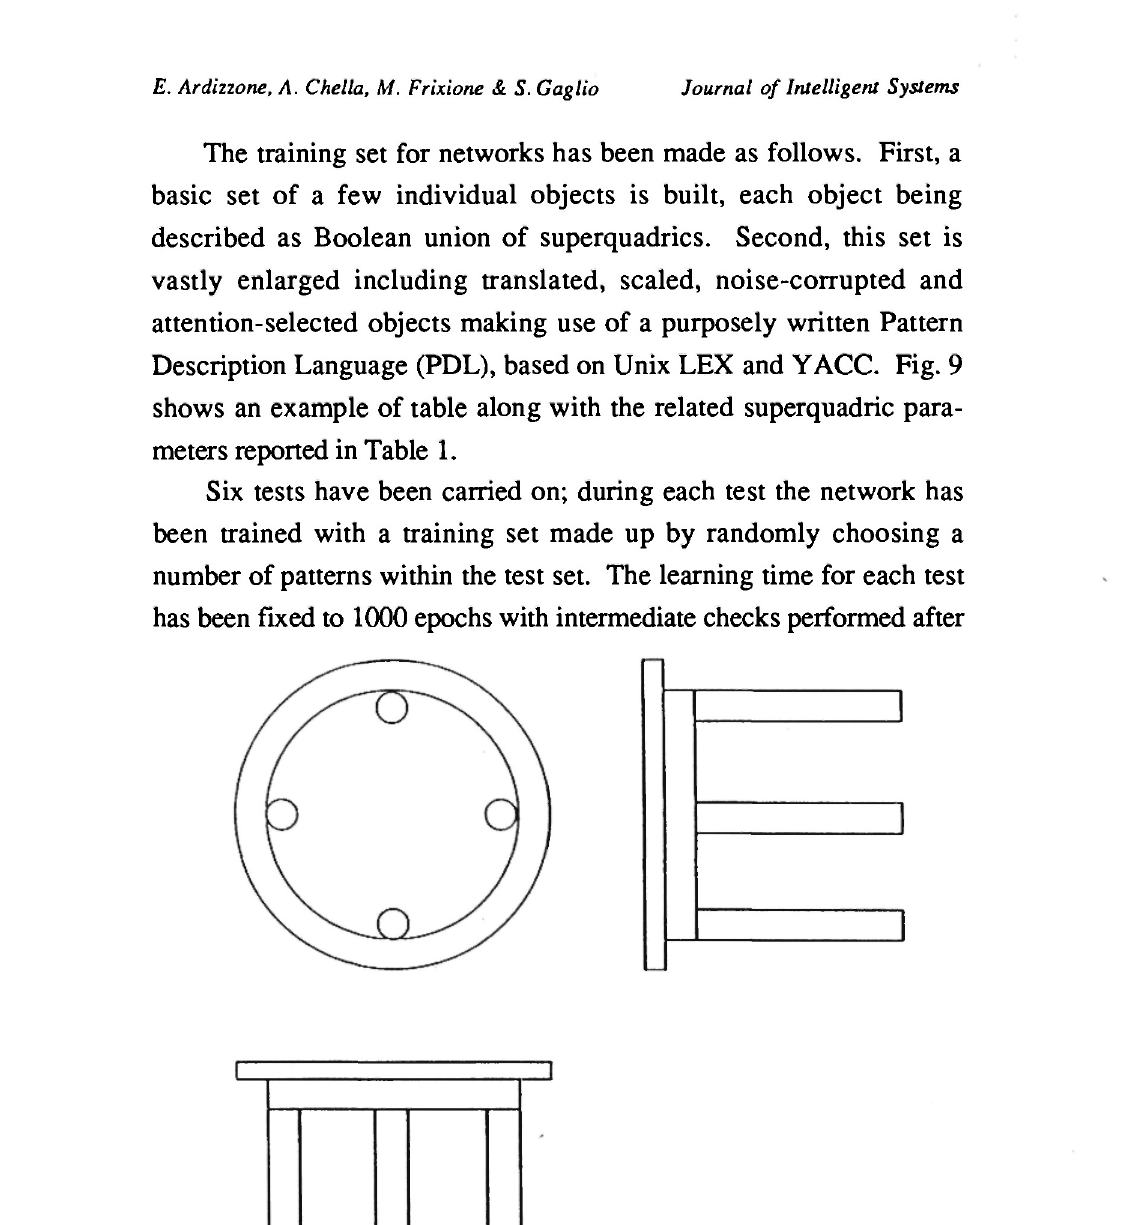
An example object of the architectures have been trained to classify and/or recognize. The corresponding superquadric parameters may be found in Table